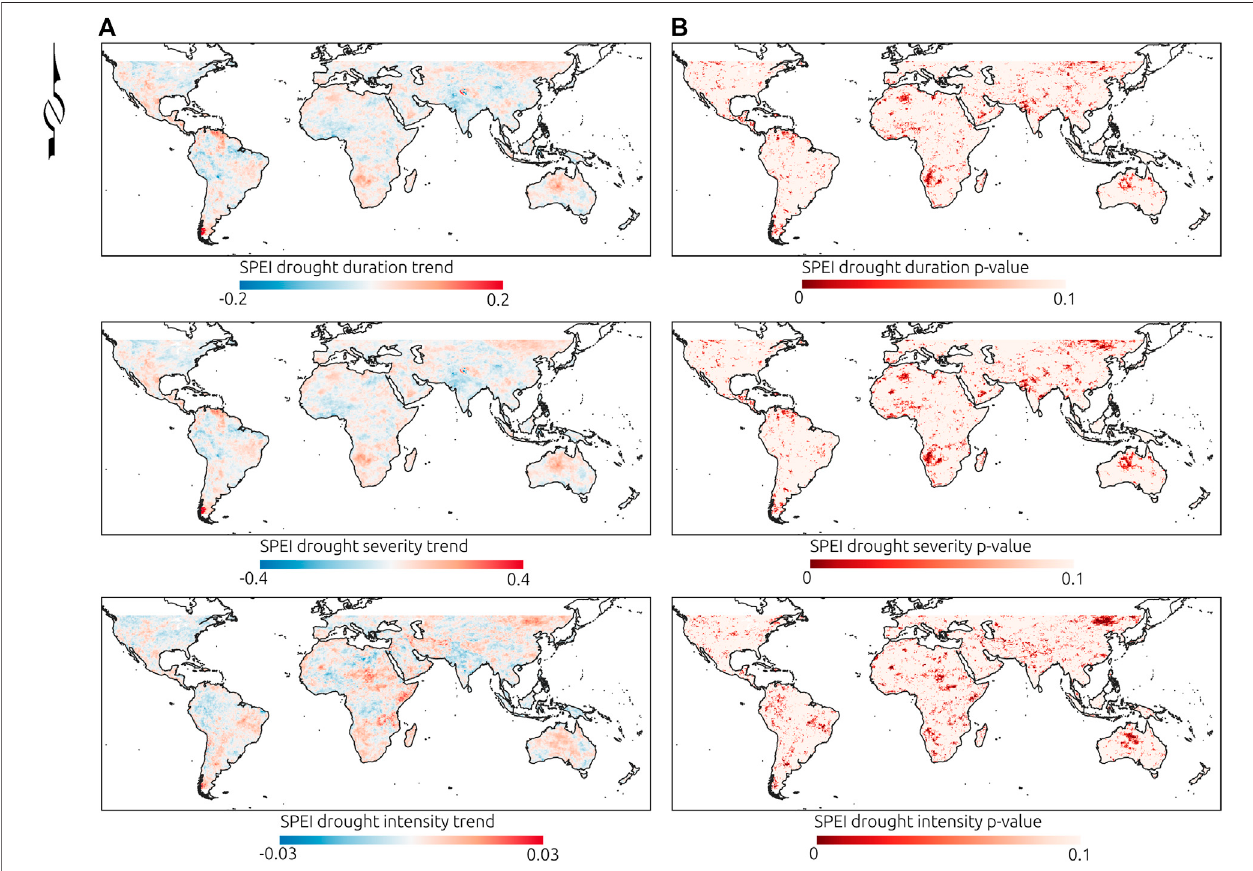
FIGURE 11 | Annual trends in the meteorological characteristics (A) and the signi fi cance of the trends from the OLS analysis (B) obtained using 3-month SPEI.